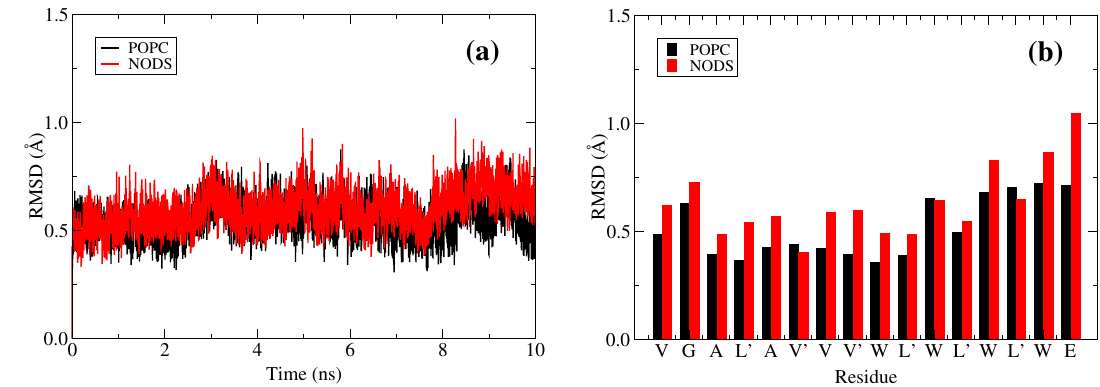
Figure 3. RMSD of gA embedded in POPC and NODS lipids: ( a ) total and ( b ) average per residue. Error bars are not shown for RMSD per residue for